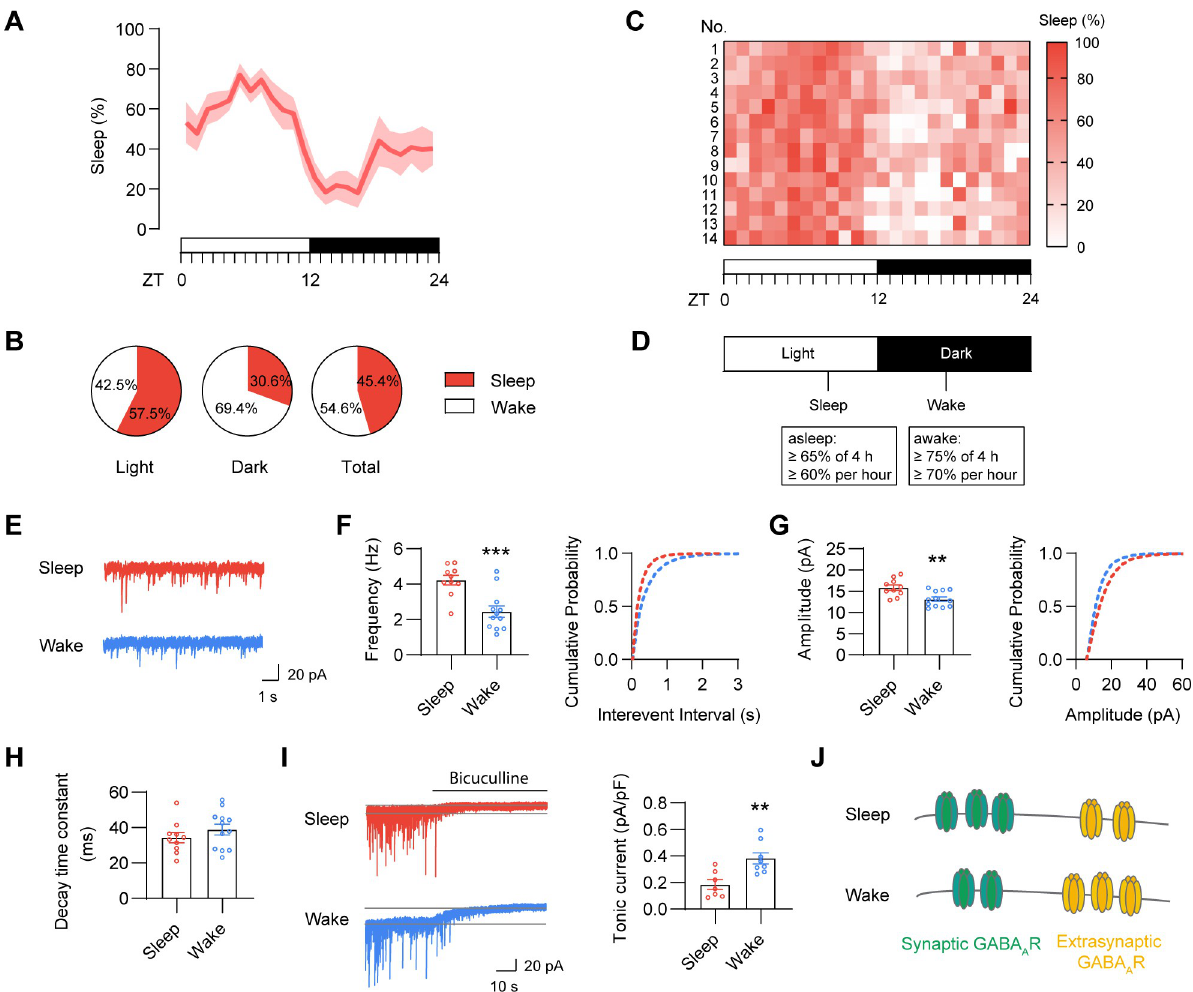
Fig 1. GABAergic transmission and GABA A R expression change across sleep and wake. (A) Sleep pattern over 24 h in wild-type 8–12 weeks old male mice ( n = 14). (B) Percentage of sleep time spent in light phase, dark phase, and the whole day ( n = 14). (C) Percentages of hourly sleep time were plotted over 24 h ( n = 14). (D) Definition of sleep/wake mice: “sleep mice” were asleep for at least 65% of the previous 4 h ( � 60% per hour), whereas “wake mice” were awake for at least 75% of the previous 4 h ( � 70% per hour). Mice were selected for electrophysiological or biochemical experiments only if they met the criteria. (E) Representative mIPSC traces from CA1 neurons in acute hippocampal slices prepared from sleep and wake mice. (F, G) mIPSC frequency and amplitude were decreased in hippocampal CA1 pyramidal neurons in wake mice compared to sleep mice ( n = 10–12, t test, frequency: p = 0.0005, amplitude: p = 0.0036). (H) There was no difference of mIPSC decay time constants in sleep and wake mice ( n = 10–12, t test). (I) Tonic inhibition was increased in hippocampal CA1 pyramidal neurons in wake mice compared to sleep mice ( n = 7–8, t test, p = 0.0043). (J) A model showing the changes of synaptic and extrasynaptic GABA A R expression across sleep and wake. The data underlying this figure can be found in S1 Data. ��� p < 0.001 and �� p < 0.01. All data are presented as mean ± SEM. mIPSC, miniature inhibitory postsynaptic